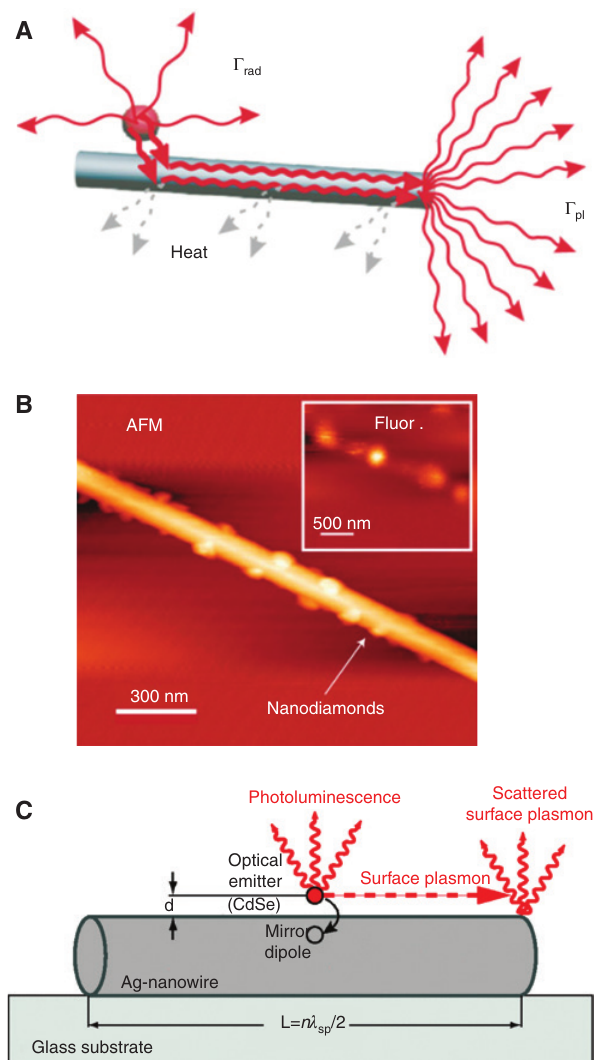
Figure 3: Experimental approaches on random single